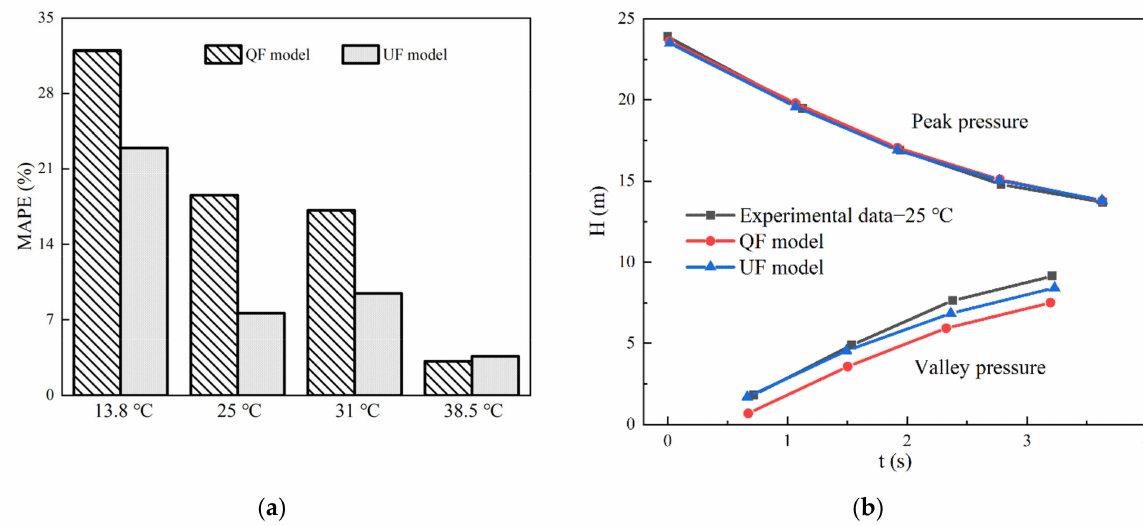
Figure 6. Comparison of the peak pressure damping results computed using the QF and UF models: ( a ) MAPE values; ( b ) peak pressure damping at 25 ◦